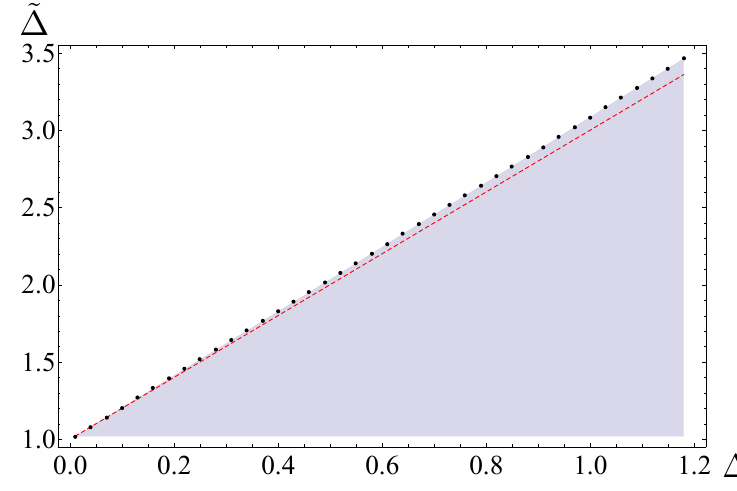
Figure 2 . Black dots: numerical bootstrap bound on the gap above identity following from (2.16), using 50 derivatives. Red dashed line: ~(cid:1) = 2(cid:1) + 1. Figure taken from